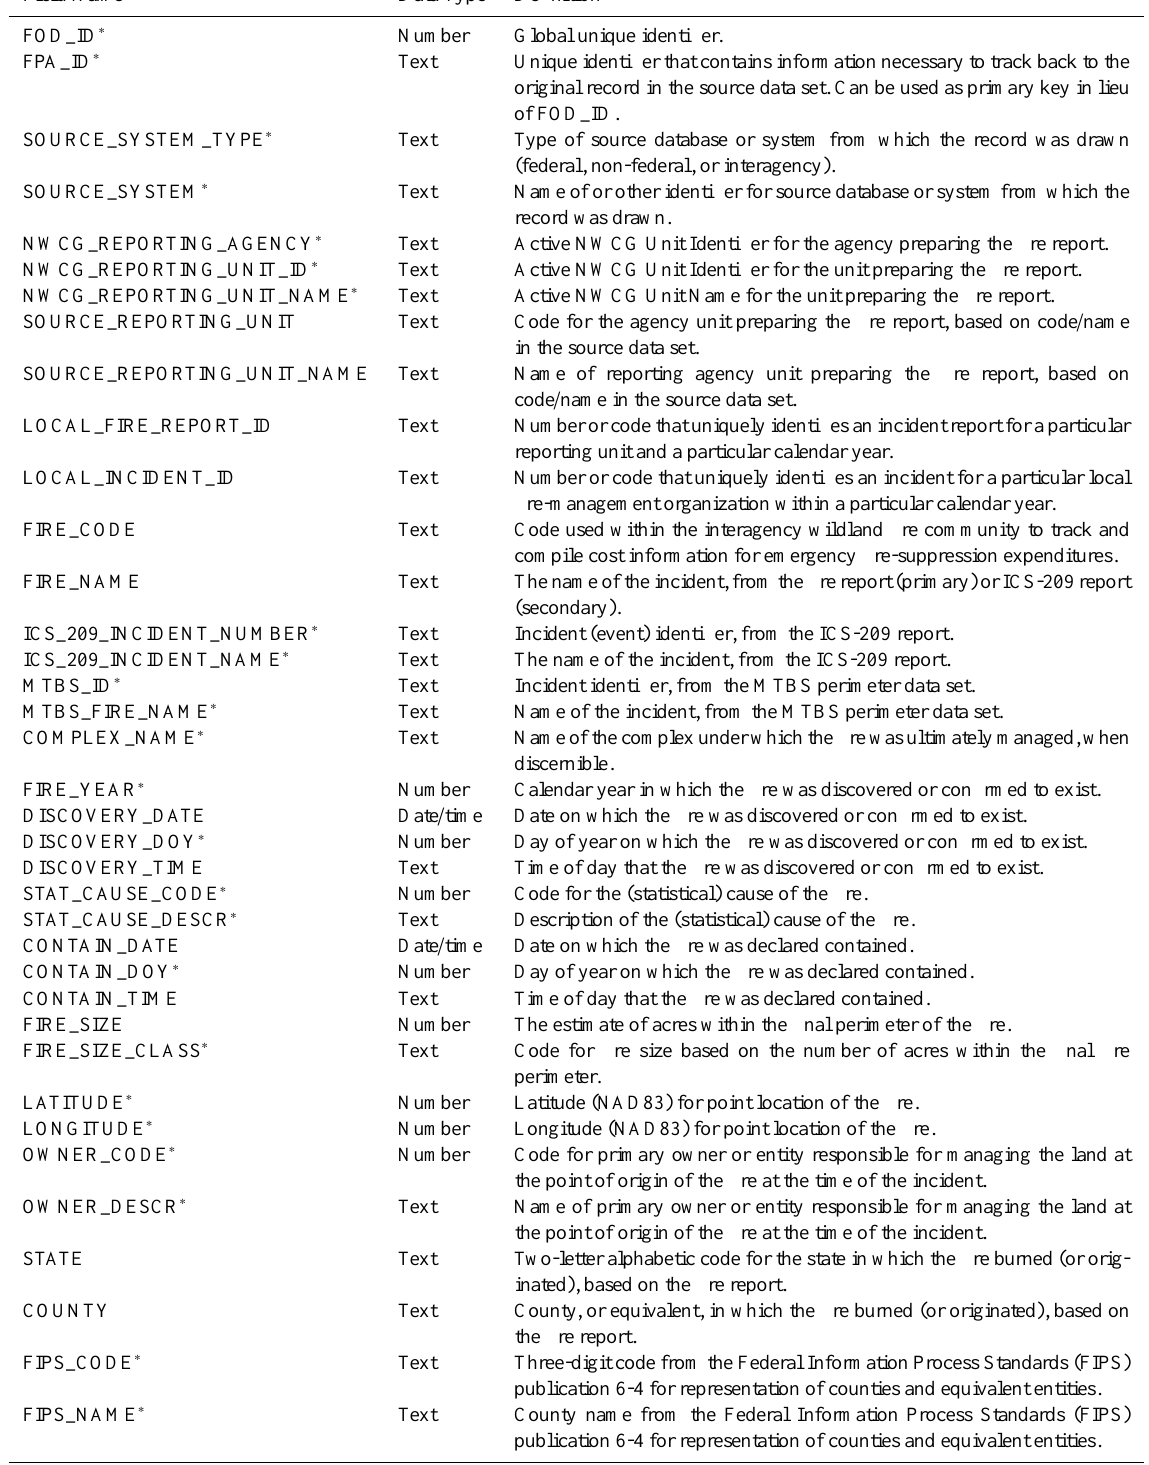
Table 6. FPA FOD Fires table